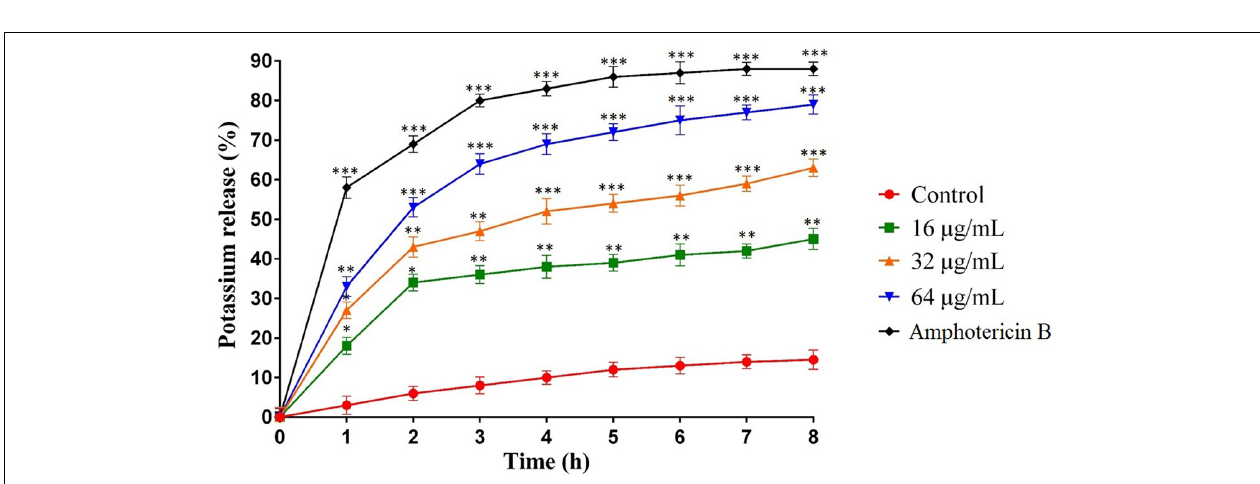
FIGURE 3 | Effect of MCh-AMP1 on the potassium release of C. albicans ATCC 10231 is indicated. C. albicans cells were treated with different concentrations of MCh-AMP1 (16–64 µ g/mL) and amphotericin B (2 µ g/mL) for 3 h. The results are based on three independent experiments and represent the average, standard deviation, and P -values ( ∗ p ≤ 0.05, ∗∗ p ≤ 0.01, ∗∗∗ p ≤ 0.001) denote statistically significant differences from the effect of MCh-AMP1 on the control cells.